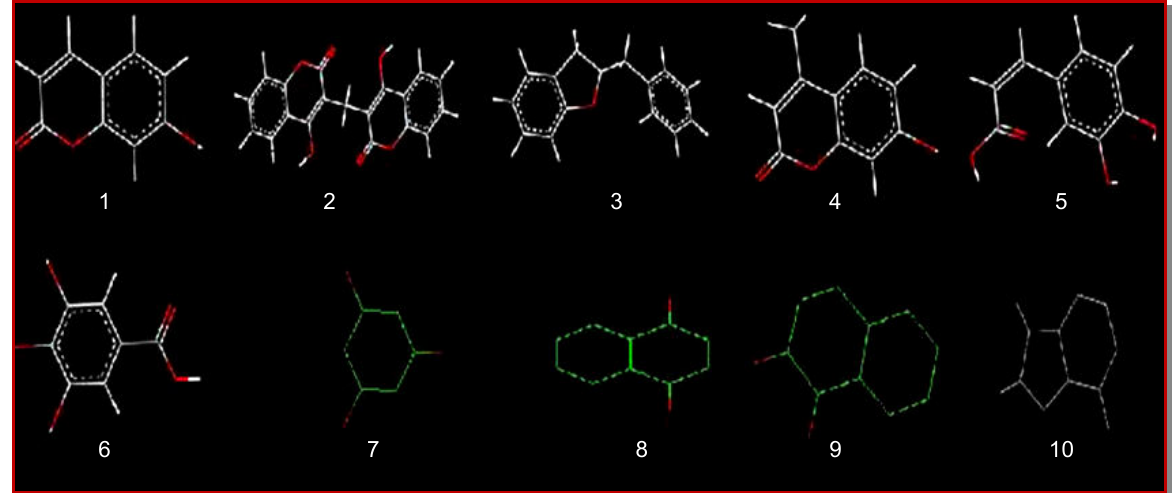
Figure 2: The optimized ligand molecules (1) 7-hydroxy coumarin, (2) bishydroxy coumarin, (3) 2-benzyl coumarin, (4) 7- hydroxy-4- methyl coumarin, (5) ferulic acid, (6) gallic acid, (7) phloroglucinol, (8) 1,4 – naphthoquinone, (9) 1,2 – naphthoquinone, (10)